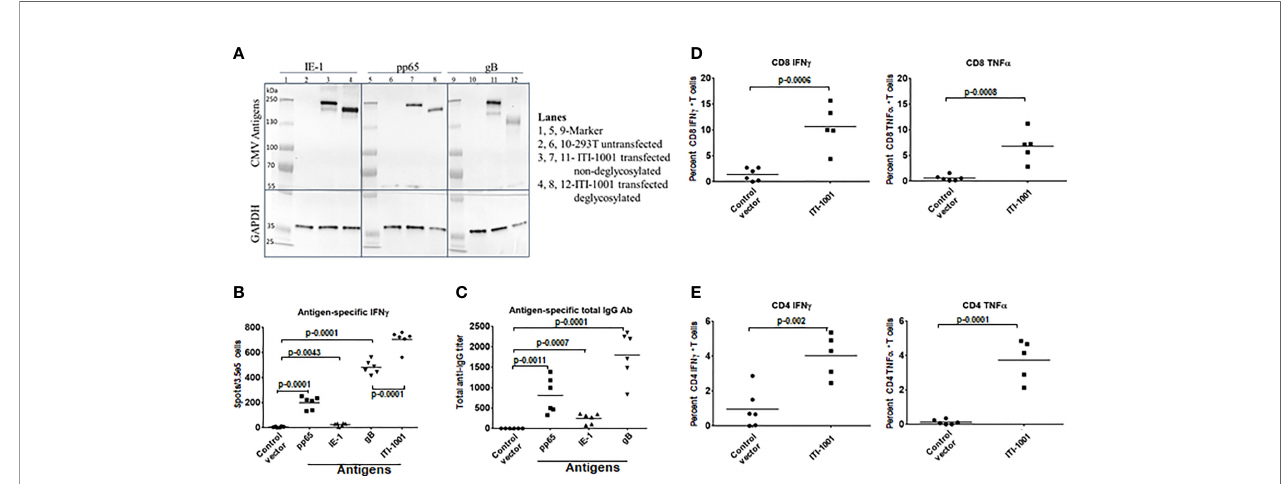
FIGURE 1 | Expression and immunological response of ITI-1001 vaccine. (A) Western blots showing the expression of IE-1, pp65, and gB HCMV antigens from ITI- 1001 in 293T cell lysates using antigen-speci fi c antibodies. Lanes 2, 6, and 10 are untransfected cell lysates. Lanes 3, 7, and 11 are ITI-1001-transfected non- deglycosylated cell lysates. Lanes 4, 8, and 12 are ITI-1001-transfected deglycosylated cell lysates. Glyceraldehyde 3-phosphate dehydrogenase was used as a loading control. Molecular weight ladder was used in lanes 1, 5, and 9 to assist in protein size determination. (B) IFN g ELISpot data with antigen-speci fi c peptides for pp65, IE-1, and gB and all three antigens combined using splenocytes. p values from Student ’ s t-test are denoted to signify the statistical differences between the groups. (C) Serum-based Enzyme linked immunosorbent assay for antigen-speci fi c total antibody detection. p values from Student ’ s t-test are denoted to signify the statistical differences between the groups. (D, E) Flow cytometric analysis of CD8 and CD4 T cells respectively for antigen-speci fi c activation and intracellular cytokine staining for IFN g and TNF a . The percent T cells in each graph are from T effector memory cell populations (CD44 + CD62 - ) for CD4 and CD8 T cells. p values from Student ’ s t-test are denoted to signify the statistical differences between the